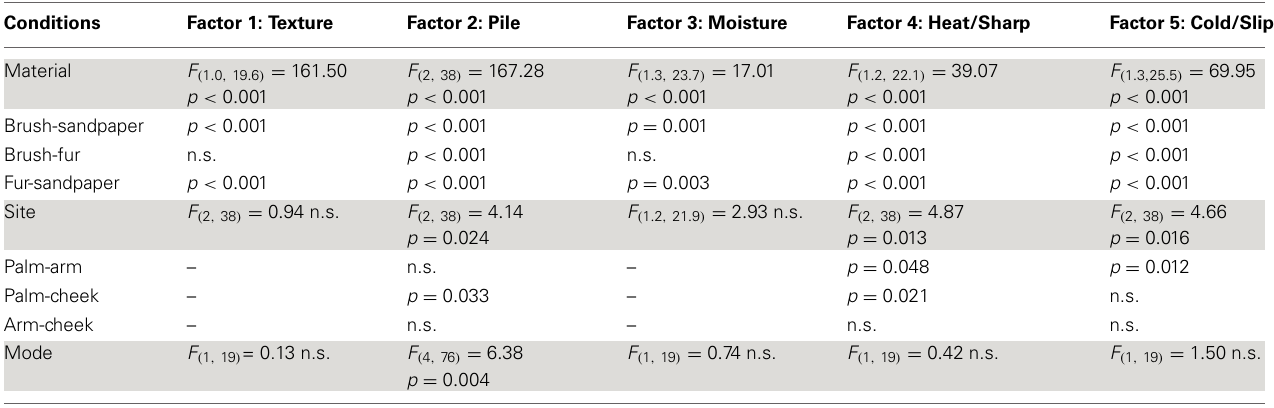
Table 3 | Significant differences for the condition type in the sensory